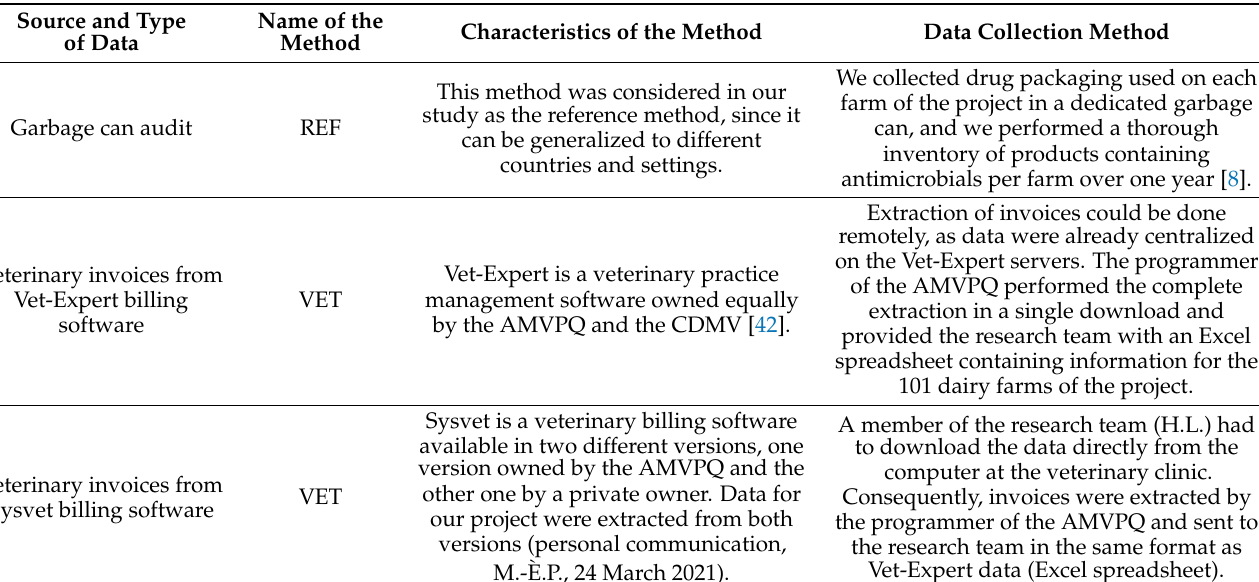
Table A1. Source and type of data and characteristics of data extraction for each of four methods used in 101 Qu é bec dairy farms for quantification of antimicrobial usage: garbage can audit (REF method), all veterinary invoices (VET method), veterinary invoices eligible for the Qu é bec governmental program (GOV method), and farm treatment records (FARM